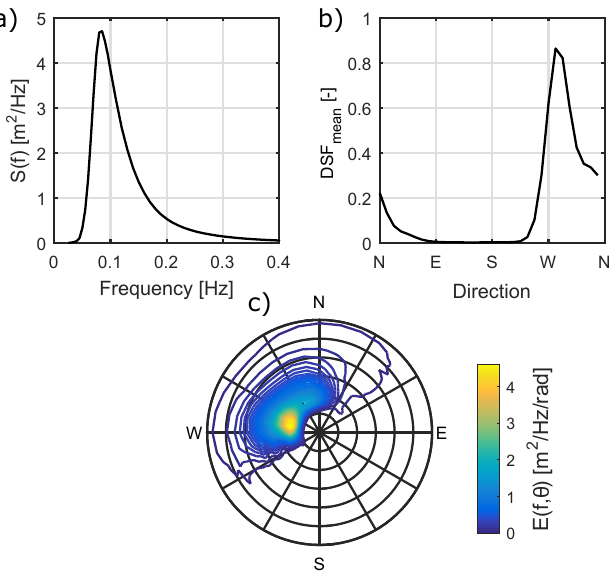
Figure 1. Mean frequency spectrum ( a ), DSF mean ( b ) and directional spectrum ( c ) for EMEC’s Billia Croo wave test